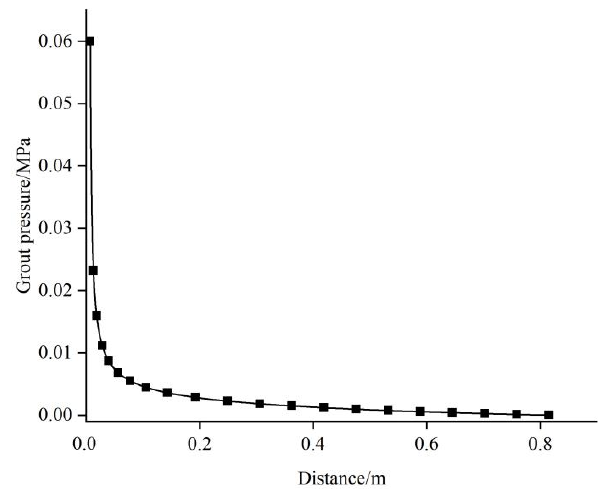
Figure 4. Pressure distribution in grout diffusion zone.